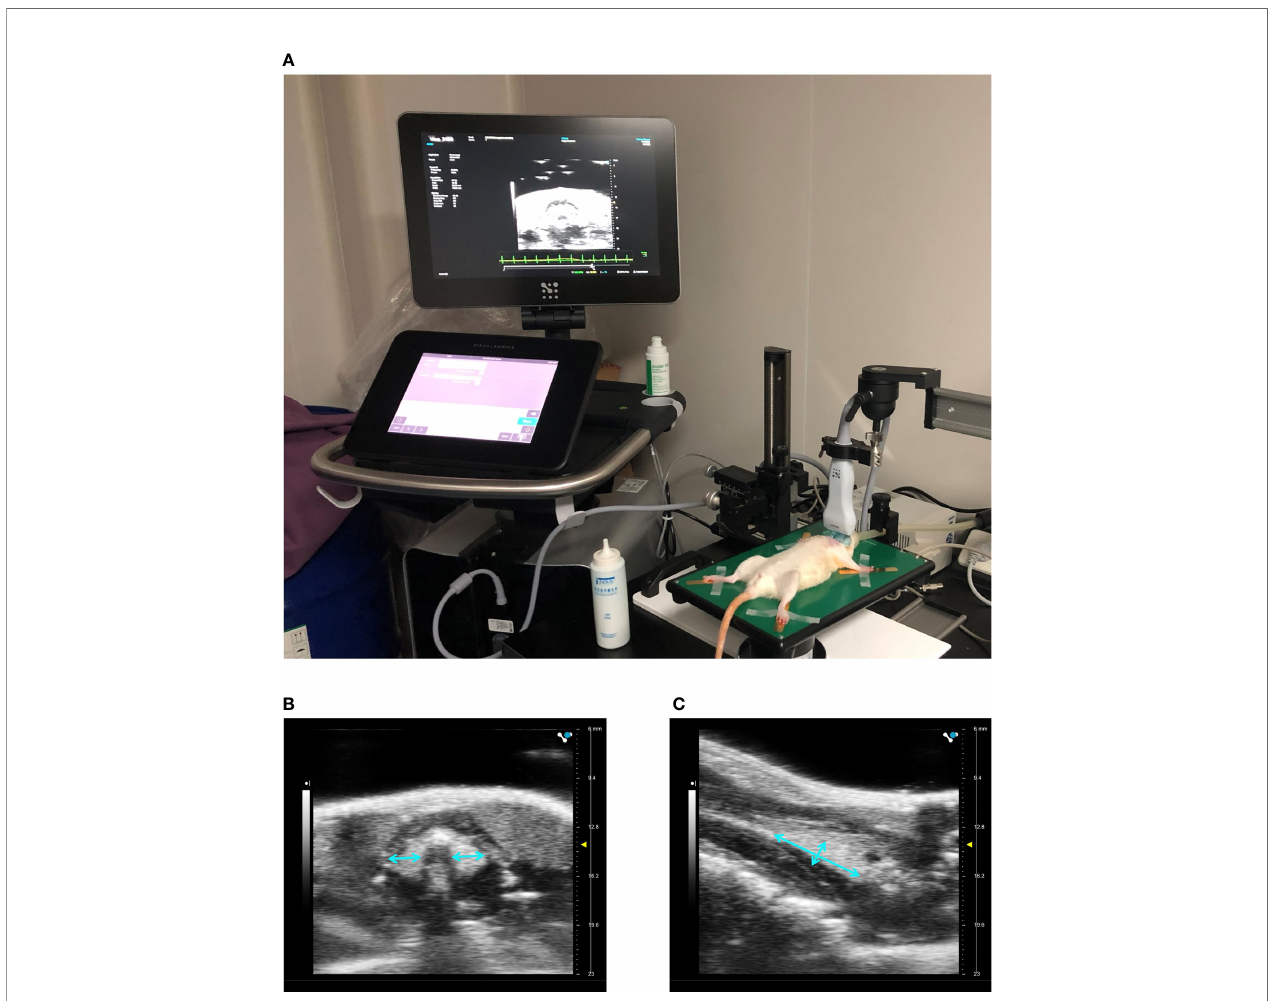
FIGURE 2 | Ultrasonography of the thyroid. Preparation and setup of a rat on the micro-imaging system (A) . Imaging in transverse (B) and sagittal planes (C) of the